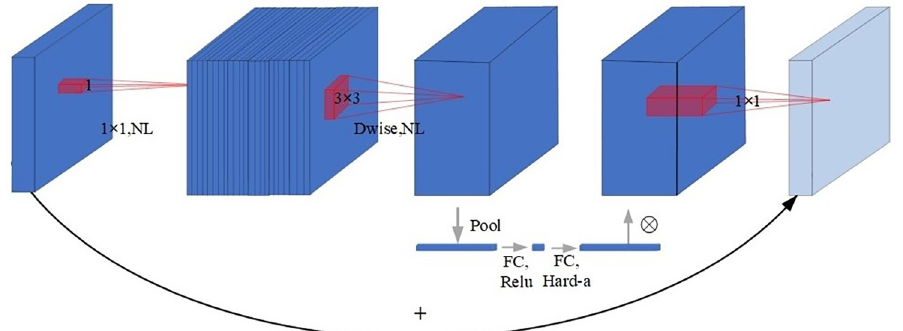
Fig 3. The structure of bneck in MobileNetV3.